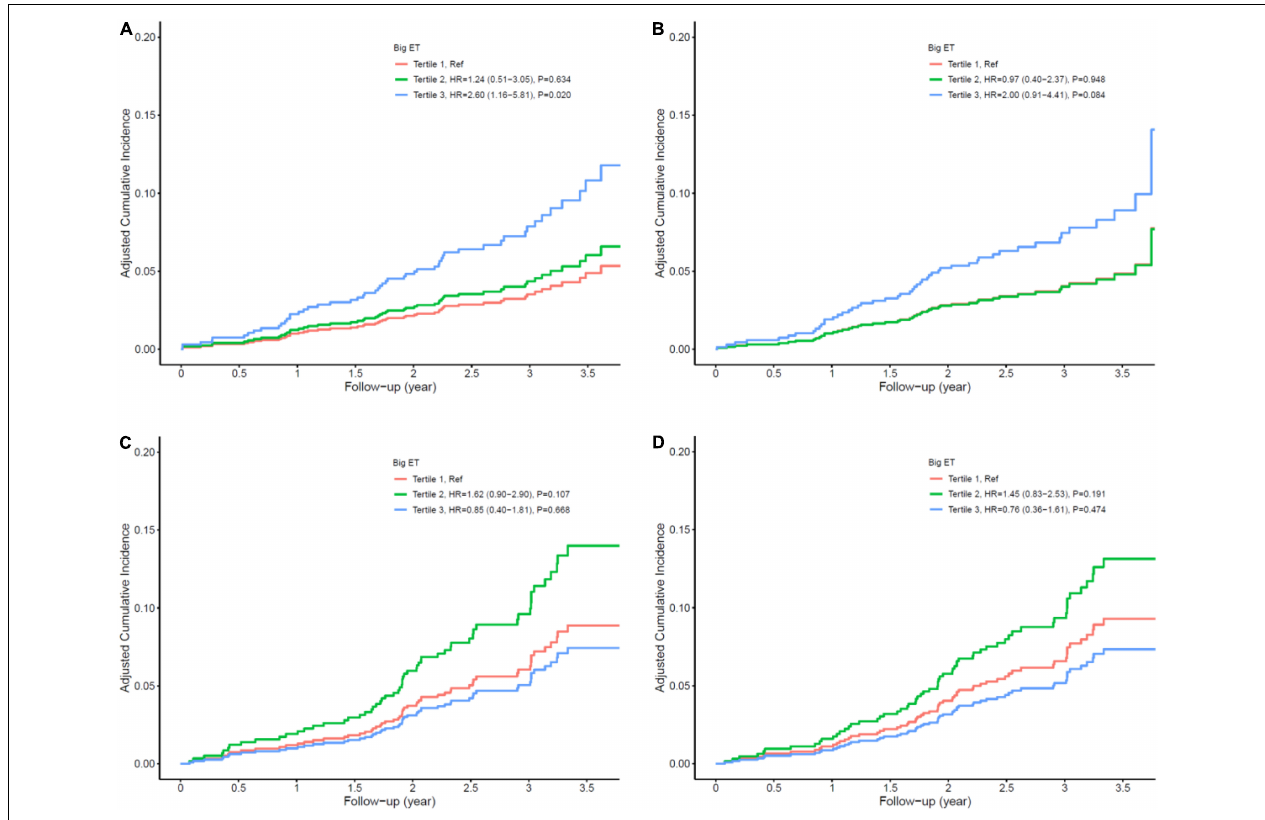
FIGURE 3 | Cox multivariate survival analysis. (A) Major adverse cardiovascular events (MACE) in diabetic patients; (B) secondary end points in diabetic patients; (C) MACE in non-diabetic patients; (D) secondary end points in non-diabetic patients.